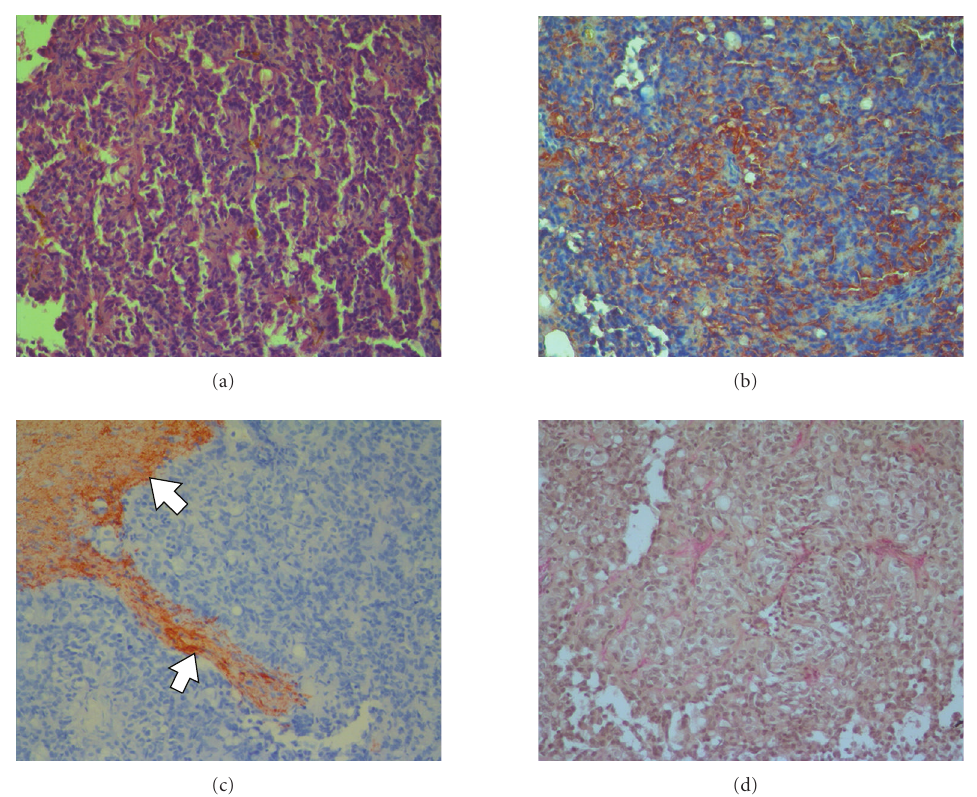
Figure 4: Papillary ependymoma: HE (a) S-100 protein (b) GFAP (c), Elastica-van-Giessen staining